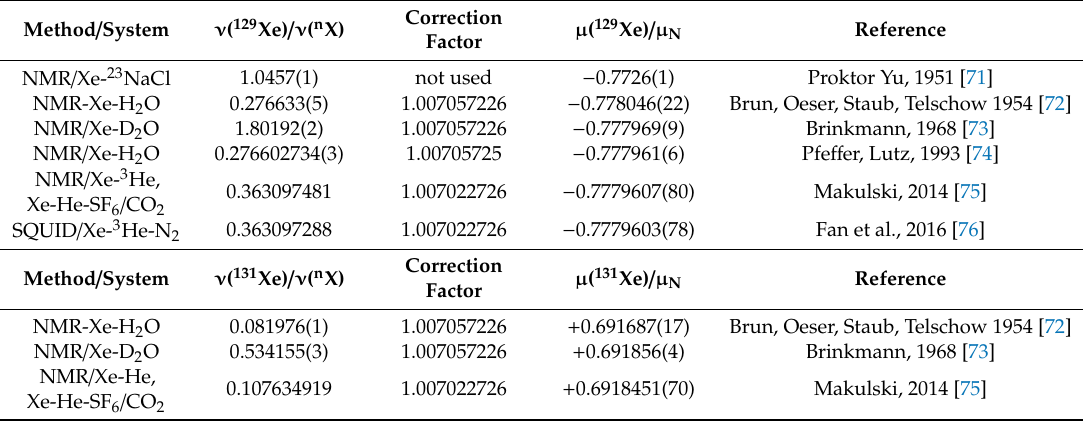
Table 6. Experimental parameters for measuring xenon nuclear magnetic